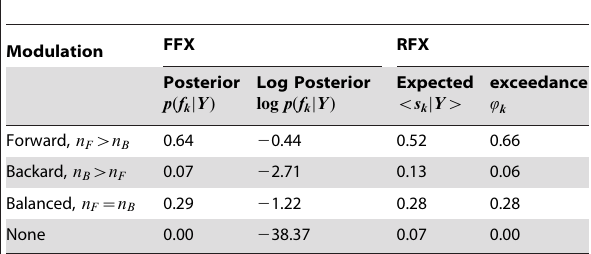
Table 2. Inference over modulatory